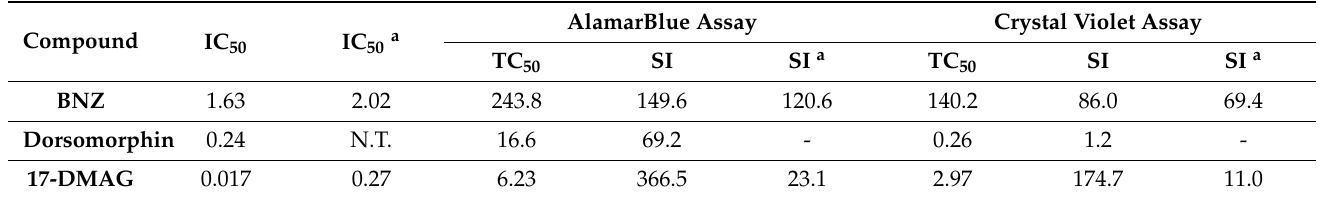
Figure 2. Anti- Trypanosoma cruzi Assay Dose–Response Curves. Graphs represent mean results and standard deviation (SD) of at least three independent biological replicas. Table 1. Table Displaying the Averaged IC 50 , TC 50 , and SI Values Obtained in the Study.